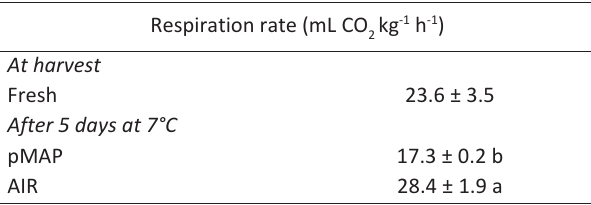
Values are means of three replicates ± standard deviation. Different letters indicate statistical differences for P≤0.05, accor­ ding to LSD